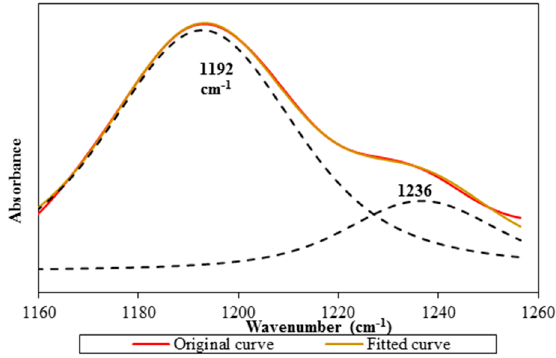
Figure 10. The original FTIR spectrum along with the fitted curve and deconvoluted peaks in the wavenumber region 1160–1260 cm − 1 .